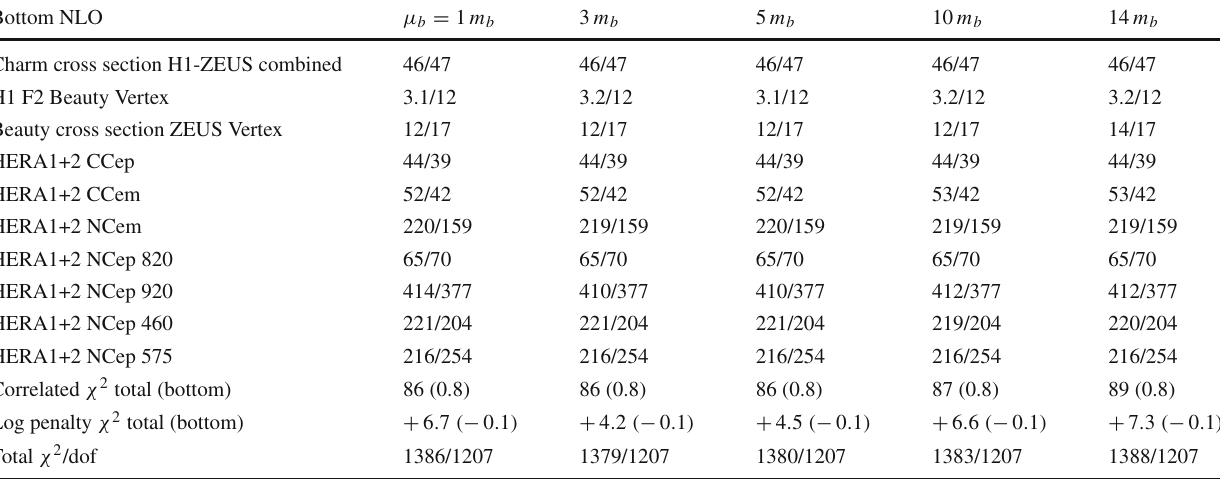
Table 3 The χ 2 values at NLO for individual data sets for a selection of the bottom matching scales μ b . The contribution of the bottom data contained in the “Correlated χ 2 ” and in the “Log penalty χ 2 ” terms is indicated separately in the parentheses Bottom NLO